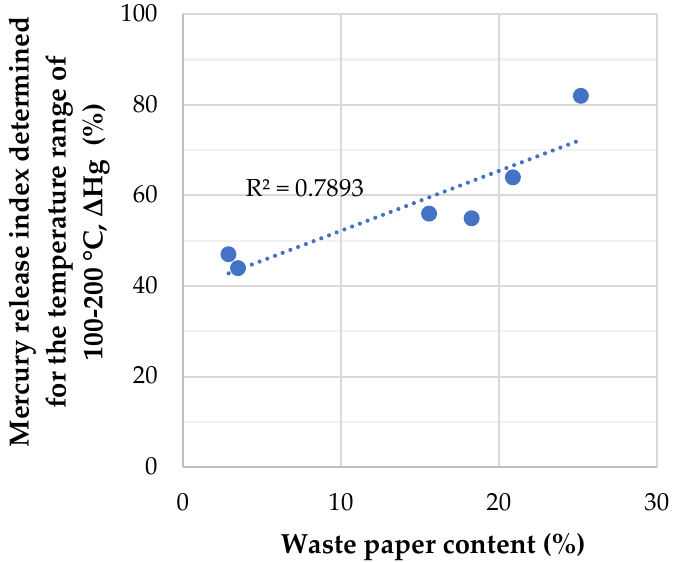
Figure 5. Relationship between the mercury release index, determined at a temperature of 100–200 °C, and the waste paper content of the RDF samples.